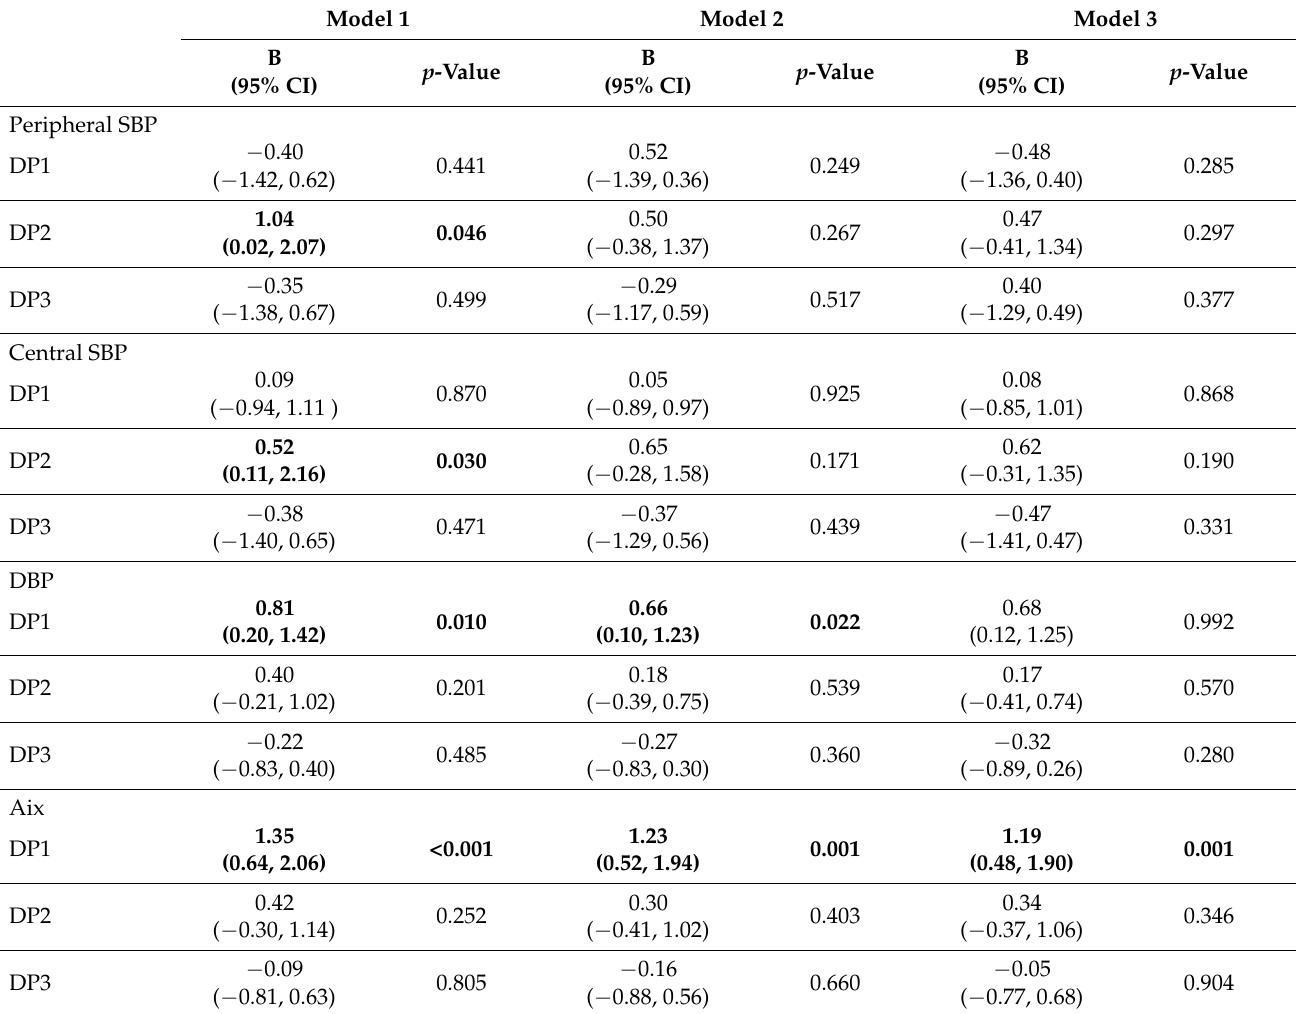
Table 7. Multiple linear regression analysis between the three identified breakfast dietary patterns and subclinical vascular